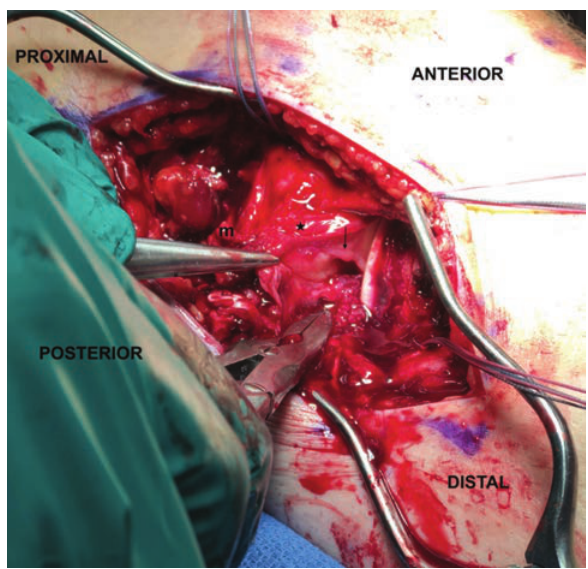
Primary repair of traumatic left knee MCL rupture Fig. 2: (arrow) using femoral and tibial suture anchors which are signified by circles.